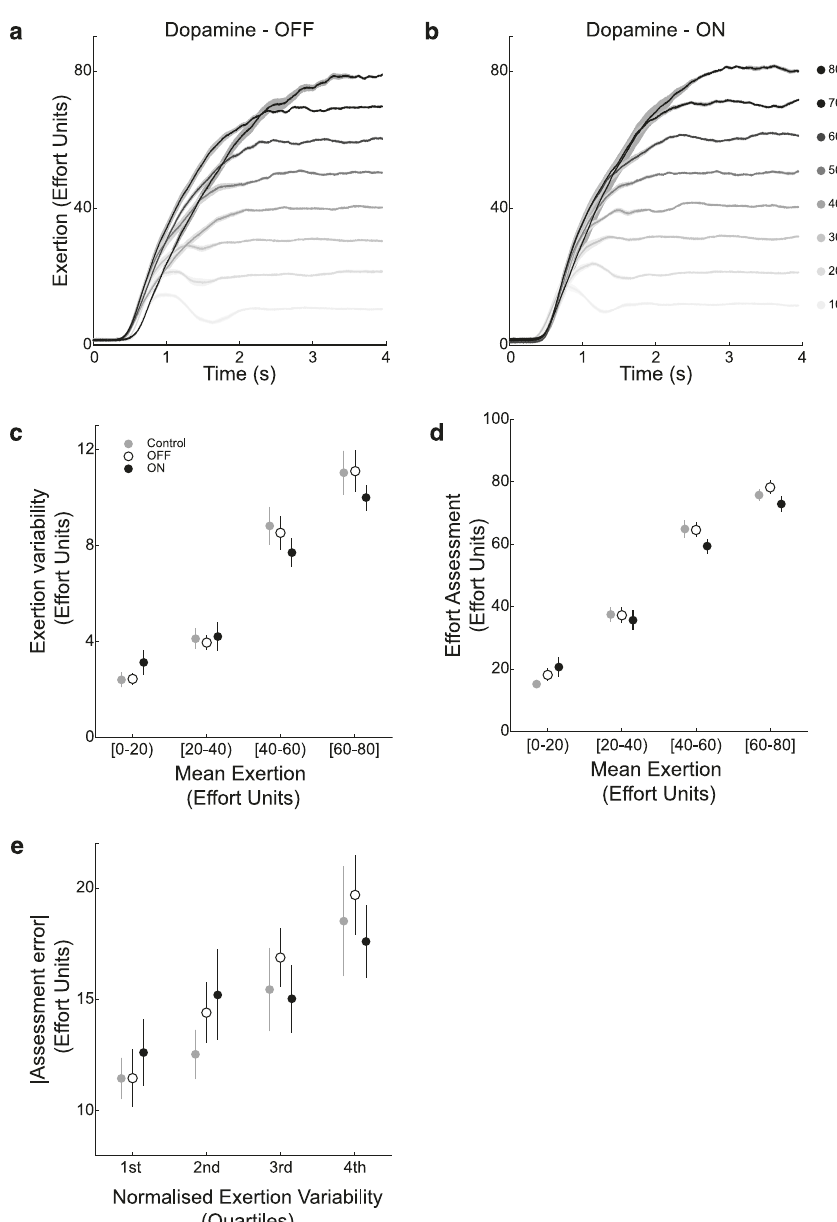
Fig. 2 Behavioral data. Mean exertion pro fi les, during the assessment phase, for a representative participant in both the a Dopamine OFF and b ON conditions. All effort levels are presented in effort units, which were relative to participants ’ maximum exertion. In both conditions, participants were able to exert to the target level and hold. The plots in Panels c – e were used for illustration purposes and not statistical inference, which was performed using mixed-effect linear models. (Control group – gray circles; OFF dopamine condition – open circles; ON condition – black circles). c Exertion variability as a function of mean exertion during the assessment phase. Exertion variability was calculated as the standard deviation of the last 3 s of exertion output. For illustration purposes, exertion variability was pooled in mean exertion bins of 20 effort units. There Error bars represent the standard error of the mean. When participants were in the Dopamine ON condition, they exhibited less of an increase in exertion variability as exertion increased, compared to OFF. Behavior for the control group matched participants in the OFF condition. d Effort assessment as a function of mean exertion during the assessment phase. Mean exertion was calculated as the average of the last 3 s of exertion output. For illustration purposes, effort assessments were pooled in mean exertion bins of 20 effort units. Error bars represent the standard error of the mean. Increased dopamine availability had a dampening effect on increases in effort assessment with exertion. Behavior for the control group matched participants in the OFF condition, and assessments were lower in the dopamine ON condition compared to controls. e Assessment errors increase with normalized exertion variability and this increase is more pronounced in the OFF-dopamine condition, compared to ON dopamine. For each trial, an assessment error metric was calculated by taking the difference between the assessed effort the mean exertion. A normalized exertion variability value was calculated by dividing exertion variability by mean exertion, which allowed performance during different levels of exertion to be evaluated in a uni fi ed model. For illustration, assessment errors and normalized exertion variability were pooled in quartiles of normalized exertion variability. Error bars represent the standard error of the mean. Increased exertion variability disrupted participants ’ assessments of effort, and increased dopamine availability had a protective effect on the propensity for exertion variability to disrupt effort assessment. Behavior for the control group was not signi fi cantly different than behavior in the ON and OFF